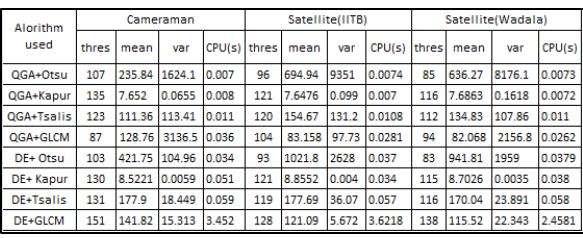
Figure 4 : Comparing execution time of various algorithm for calculating thresholds for 20 different images